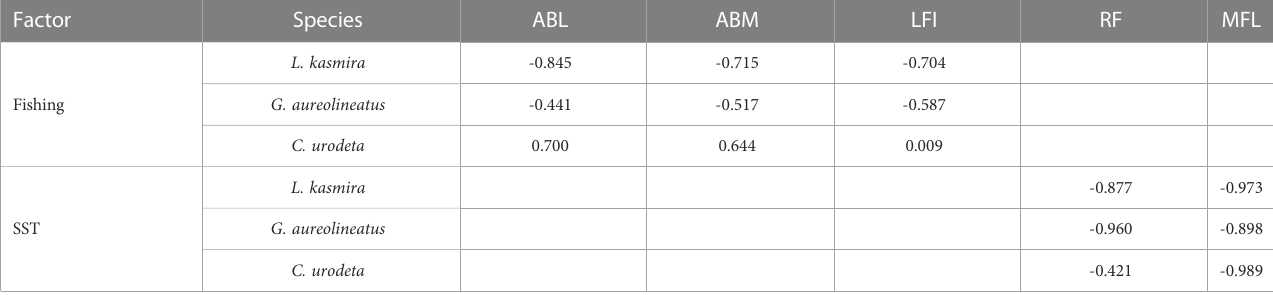
TABLE 1 Pearson correlation between fi sh biology and parrot fi sh catches and